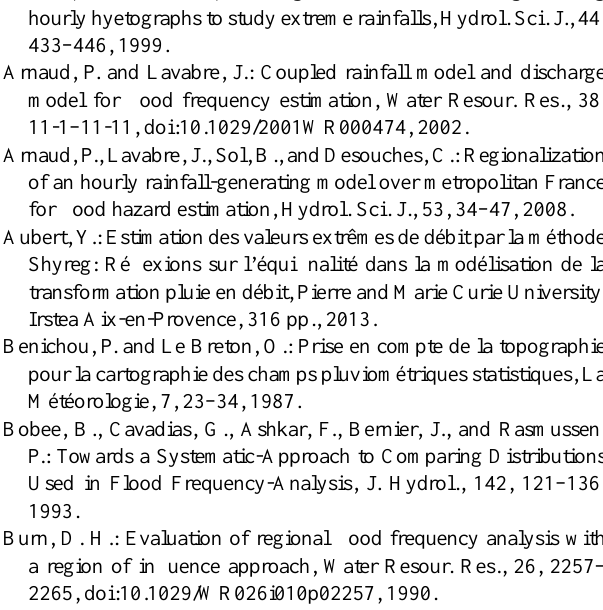
relationship with catchment characteristics could be